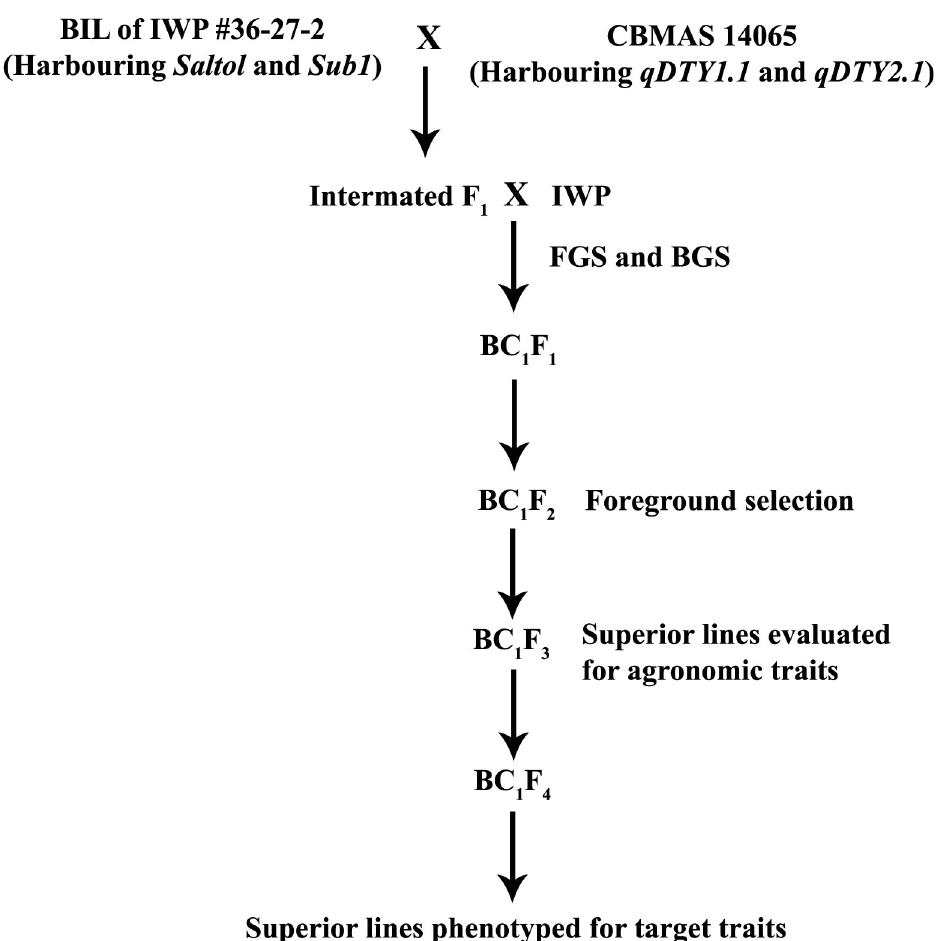
Fig 1. Pseudo back cross breeding plan for the development of multiple abiotic stress-tolerant version of IWP.